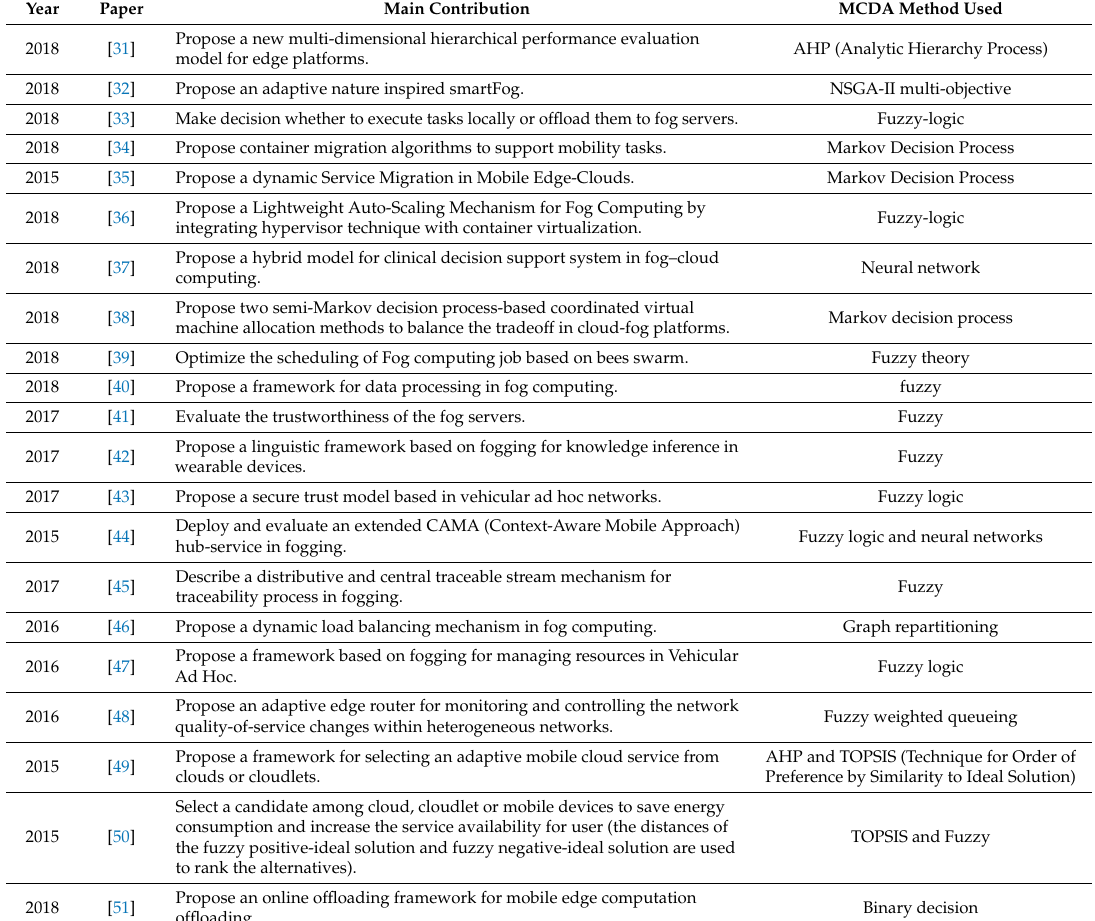
Table 1. Applied multiple criteria decision analysis methods in edge